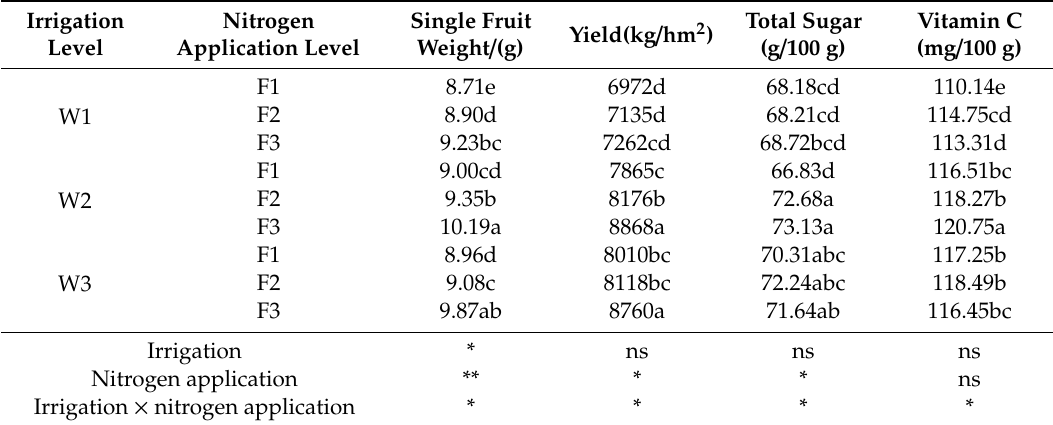
Table 4. Output of jujube for water and nitrogen